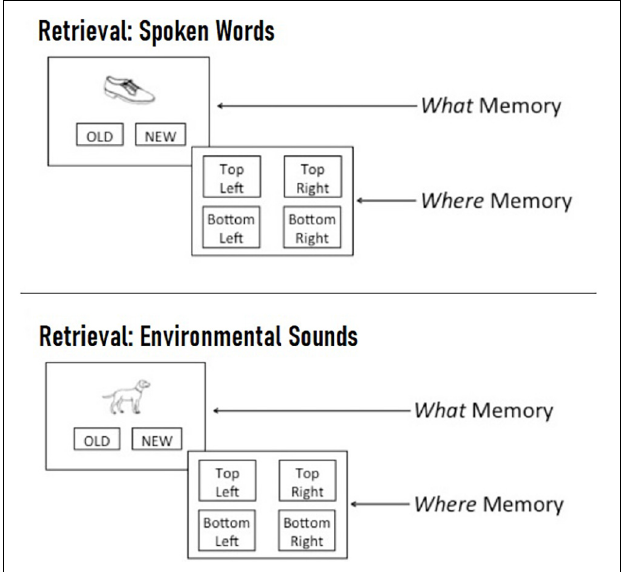
FIGURE 3 | Example spoken word (Top) and environmental sound (Bottom) retrieval trial. On each trial, participants were first presented with a single picture in the center of the screen and asked to indicate whether they recognized it from the encoding phase by clicking “old” or whether it was not previously seen by clicking “new.” If a picture was designated as “old,” participants were then asked to indicate the spatial location where the picture appeared during the encoding phase by clicking on one of four quadrants labeled “top left,” “top right,” “bottom left,” or “bottom right.”